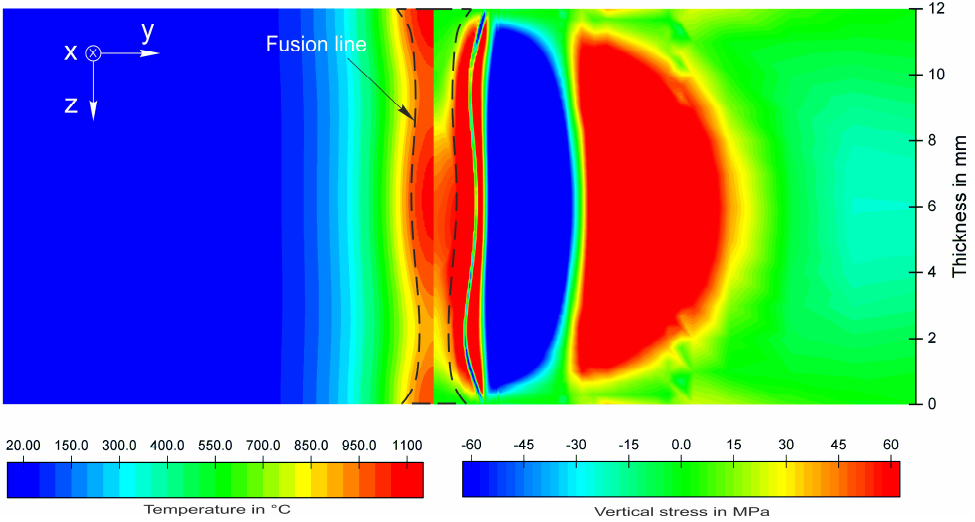
Figure 14. Vertical stress distribution and corresponding temperature distribution after solidification of the weld pool.